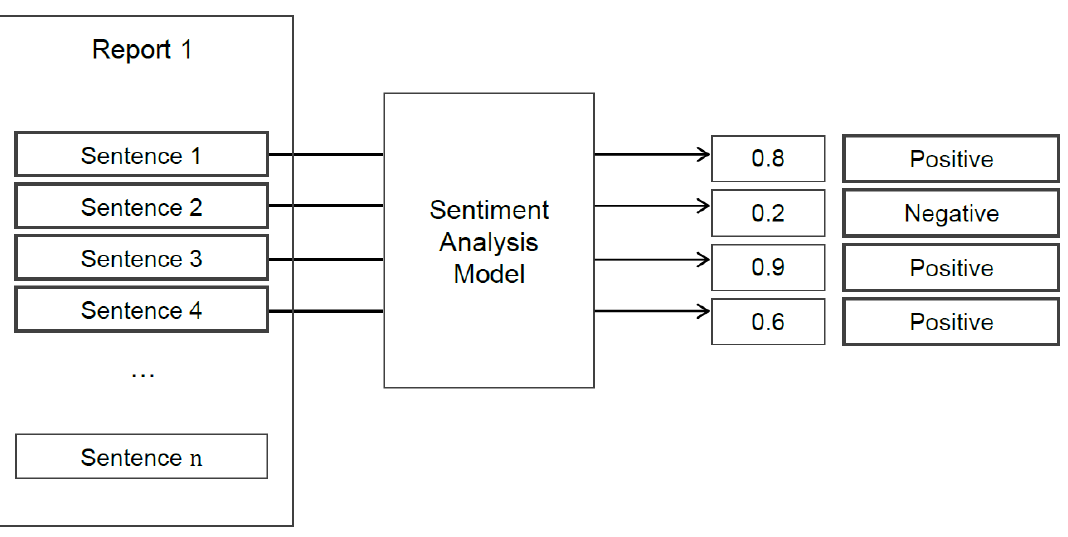
Figure 3. The sentiment analysis process. Source: the authors.